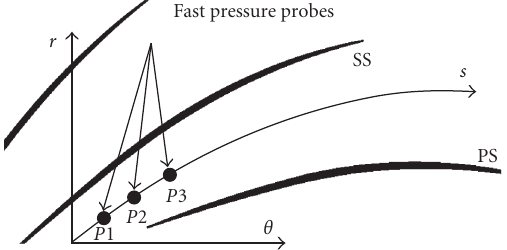
Figure 3: Location of fast pressure sensors in the di ff user